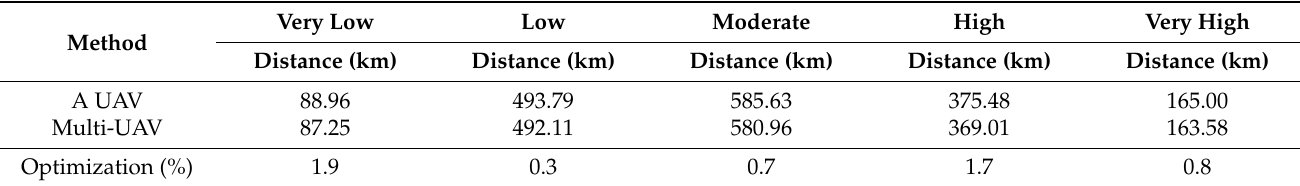
Figure 5. Multi-UAV paths: ( a ) very low risk; ( b ) low risk; ( c ) moderate risk; ( d ) high risk; ( e ) very high risk. Table 4. Comparison between single and multiple